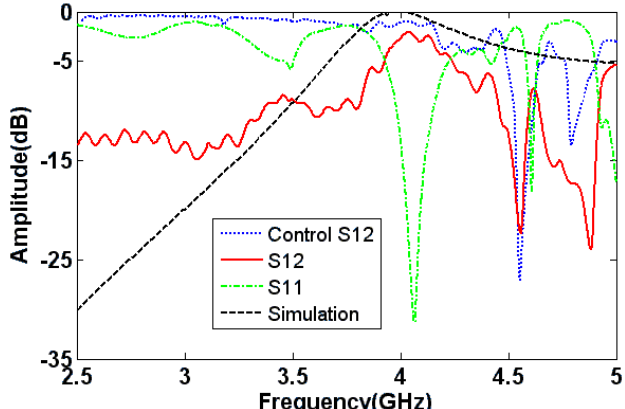
Figure 8. Experimental S-parameters for the 3D waveguide bend, the control waveguide.